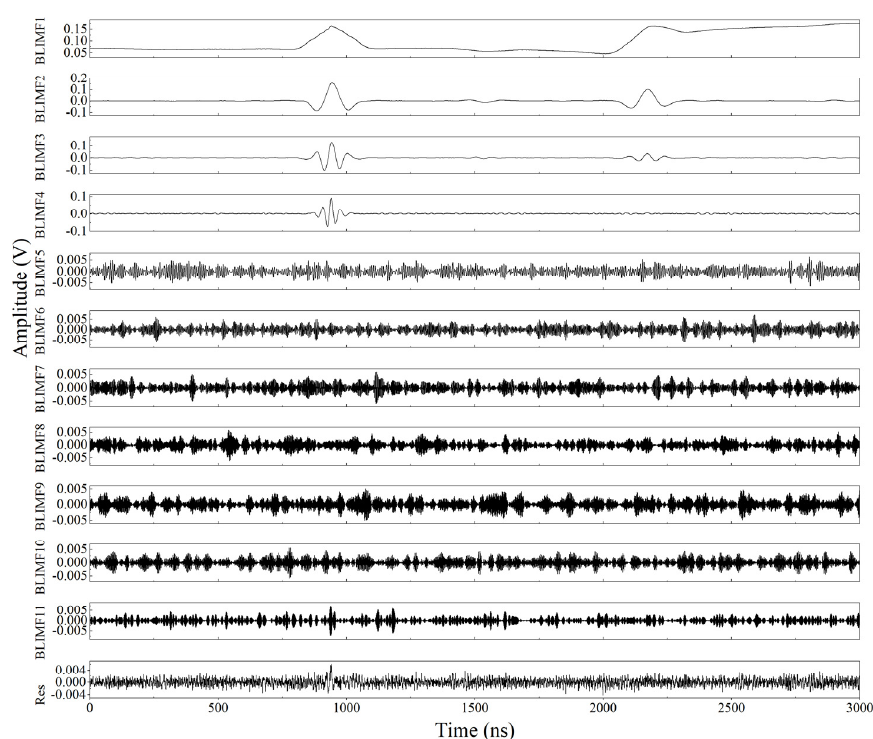
Figure 8. BLIMFs decomposed by the VMD method for the ultrasonic signal.